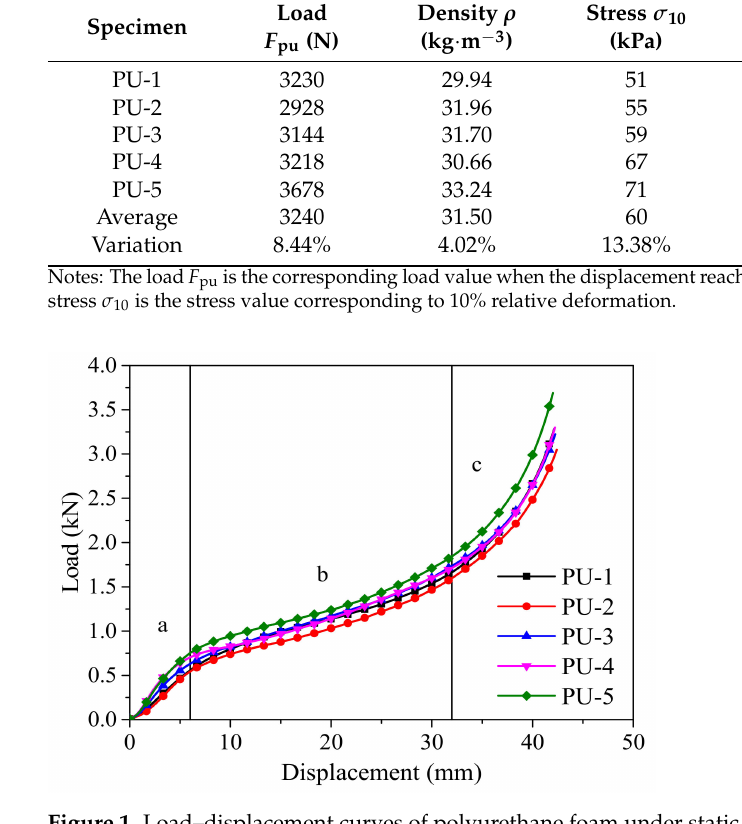
Figure 1. Load–displacement curves of polyurethane foam under static compression. ( a ) elastic stage; ( b ) platform stage; ( c ) dense